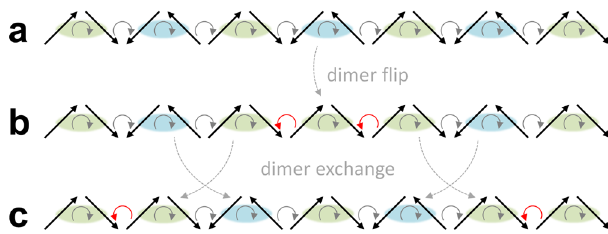
Fig. 5 Chiral solitons. a The pristine spin chain with uniform clockwise vector handedness. Dimers are marked by colored backgrounds to differentiate between the alternating species that make up the uniform spin chain. b By fl ipping both spins in a dimer it transforms into the other species and two chiral solitons are created. This process is slightly gapped due to the presence of interchain coupling in LiCuVO 4 . c By exchanging two neighboring dimers the soliton can move through the spin chain without creating additional changes in its handedness. Based on ref. 8